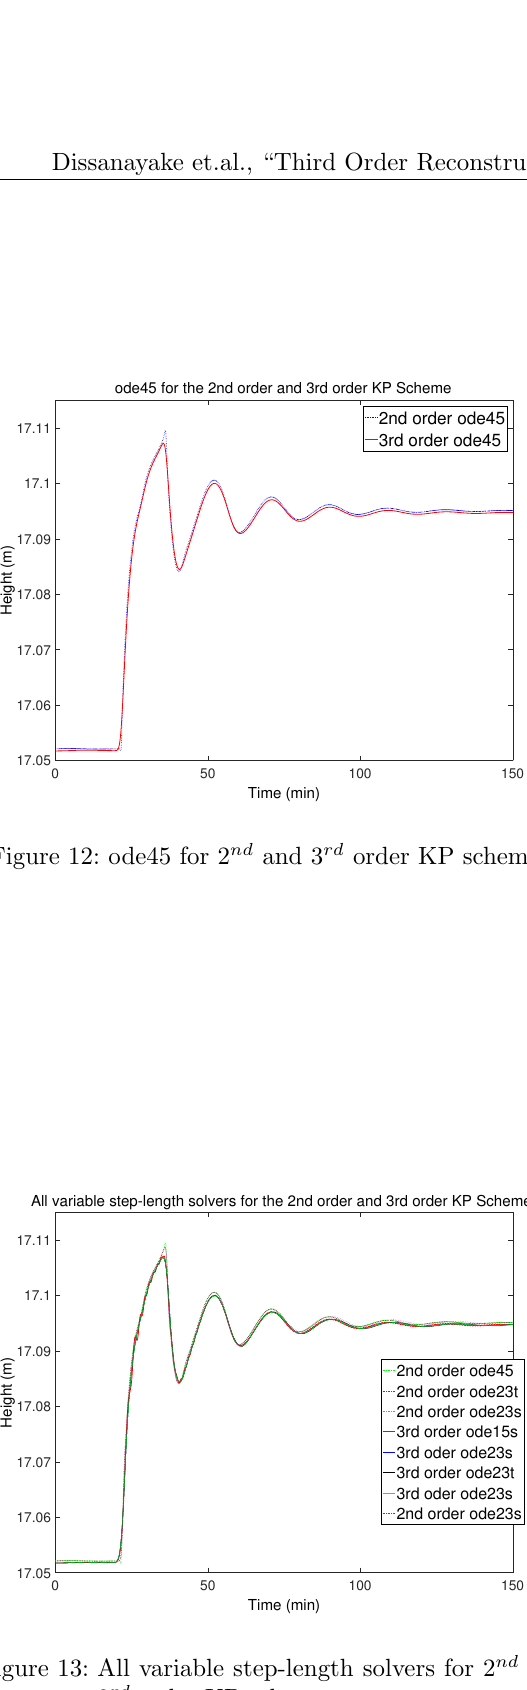
Figure 13: All variable step-length solvers for 2 nd and 3 rd order KP scheme.